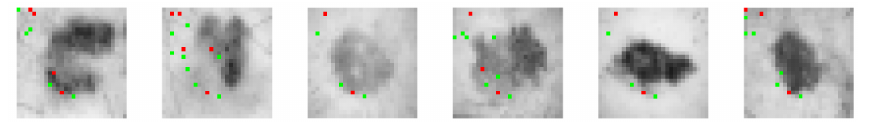
Figure 17. Samples belonging to the “benign” class, sharing a rule. The third and the fifth case are covered by a single rule, while the others present a higher number of colored dots related up to four activated rules.